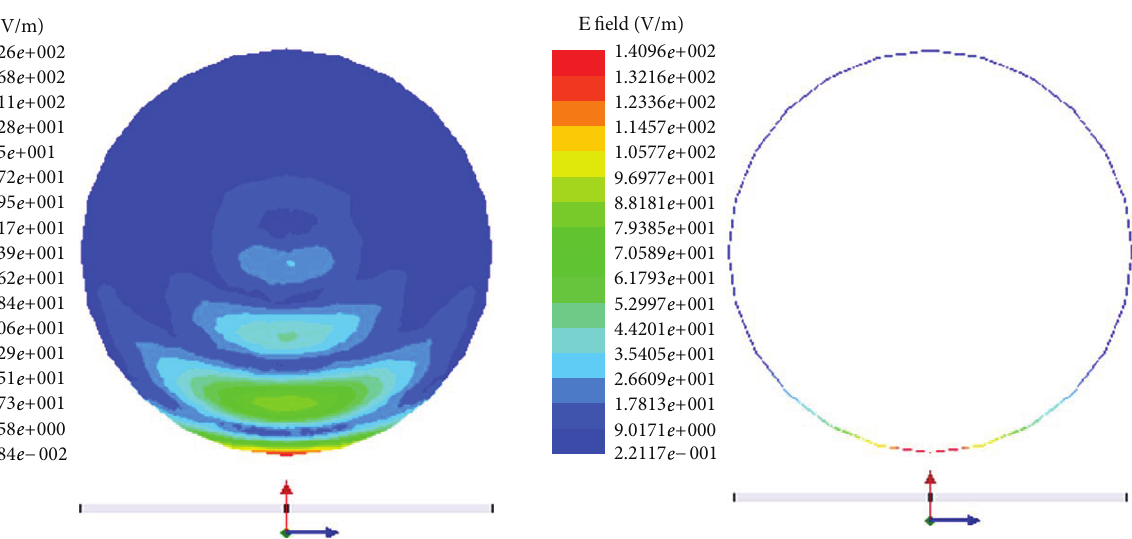
F 10: �-�eld strength in Dura tissue at 900���.